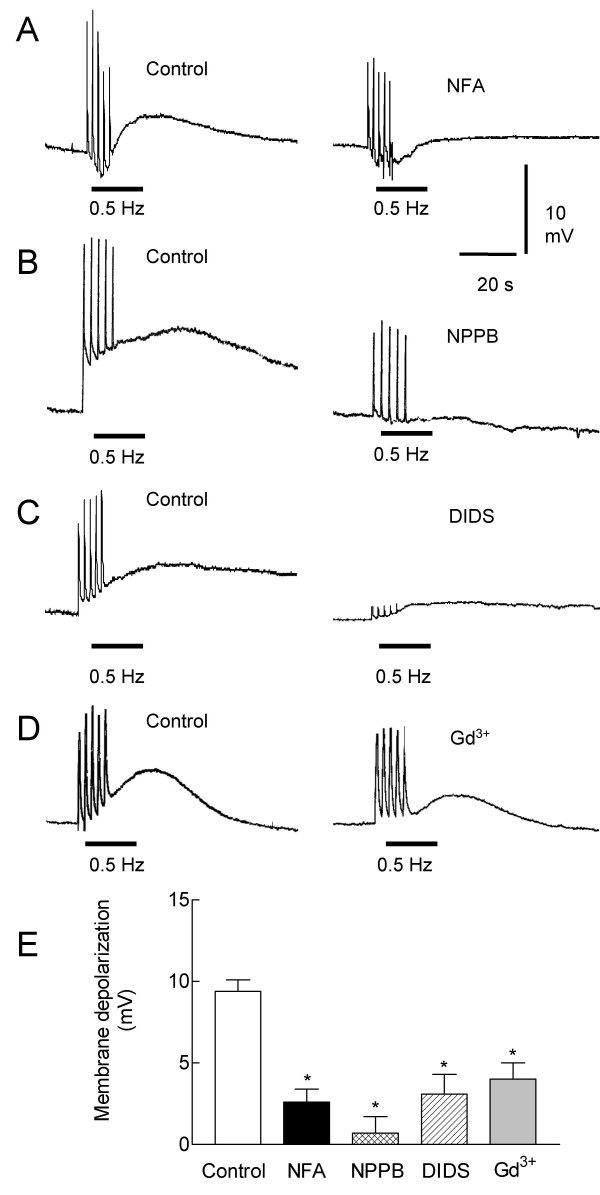
The EFS-induced slow membrane depolarization of canine isolated mesenteric vein is reduced by various ion channel inhibitors. Intracellular recordings of membrane potential in response to EFS (0.1 ms, 13 V, 10 s, 0.5 Hz) in canine isolated mesenteric veins preincubated for 60 min prior to and throughout the experiment with 100 μM NFA (A), 30 μM NPPB (B), 200 μM DIDS (C) and 30 μM Gd3+ (D). The experimental data are presented as mean ± SEM, n = 3–4 (E). *, P < 0.05 versus control. Scale bars apply to traces A-D.